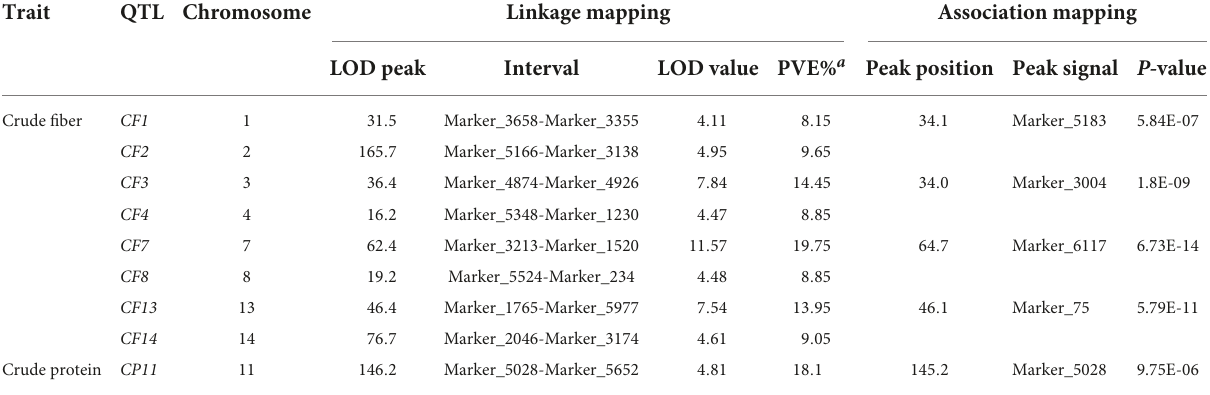
TABLE 1 QTLs for the crude fiber and crude protein content detected in the F 2 population derived from cultivated ZSZ1 and wild tenacissima. Trait QTL